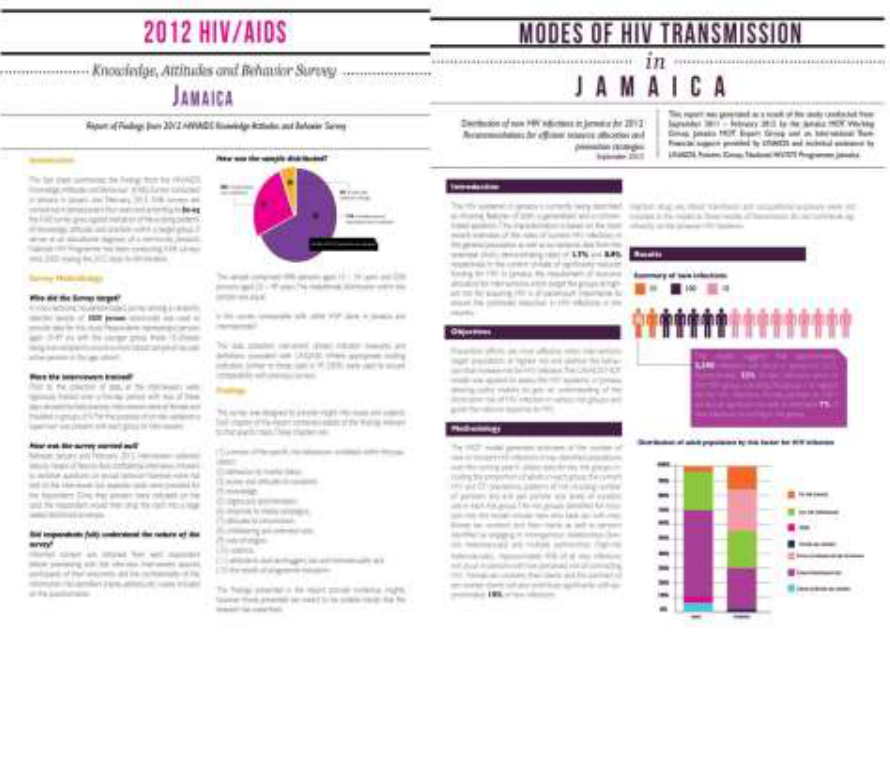
. Figure 12: Sample of fact sheets on major research that were disseminated at 2012 Annual HIV Program Review